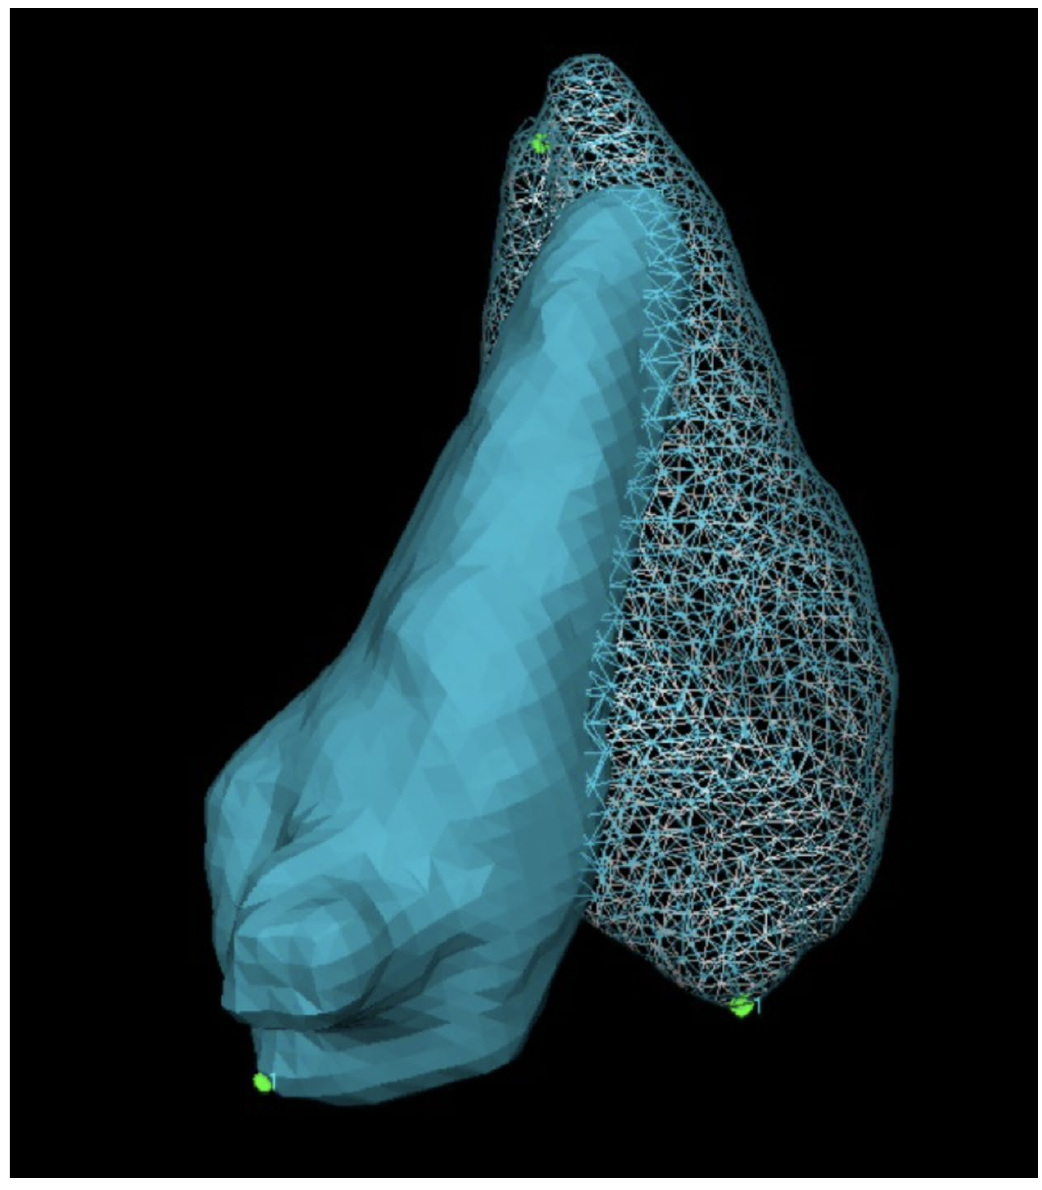
Figure 3. Superimposition and comparison of the same canine before treatment and at T2.